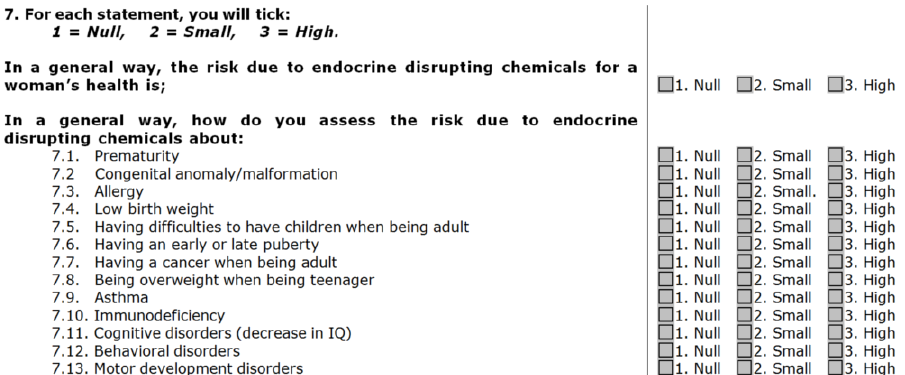
Figure A1. Items for sub-score of perceived severity (translated from French).